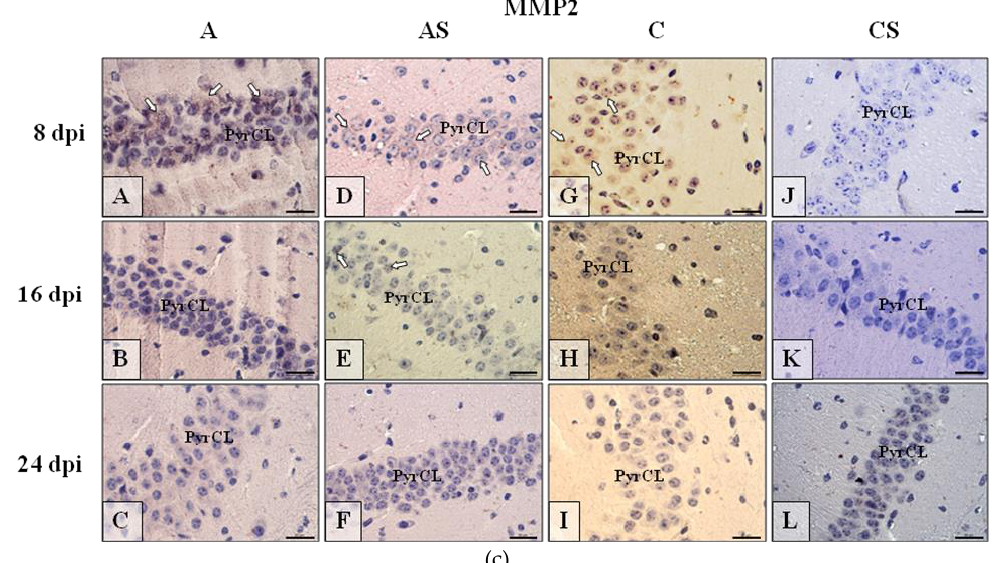
Figure 5. ( a ) Representative microphotography showing immunoexpression (brown color) of matrix metalloproteinases-2 (MMP-2) in the neocortex of mice from control group (a, G–I), immunosuppressed uninfected control group (a, J–L), immunocompetent infected by Acanthamoeba spp. (a, A–C) and immunosuppressed Acanthamoeba spp. infected group (a, D–F) in 8, 16, and 24 day post infection (dpi). White arrows show immunoexpression of MMP-2 in the neurons of cerebral cortex at the beginning of experiment (5a, A,D,G,J); in following days of experiment (5a, B,C,E,F,H,I,K,L) the MMP-2 in IHC procedure is under detection level. ( b ) Representative microphotography showing immunoexpression (brown color) of MMP-2 in neurons of granular cell layer (GCL) of the gyrus dentatus of mice from